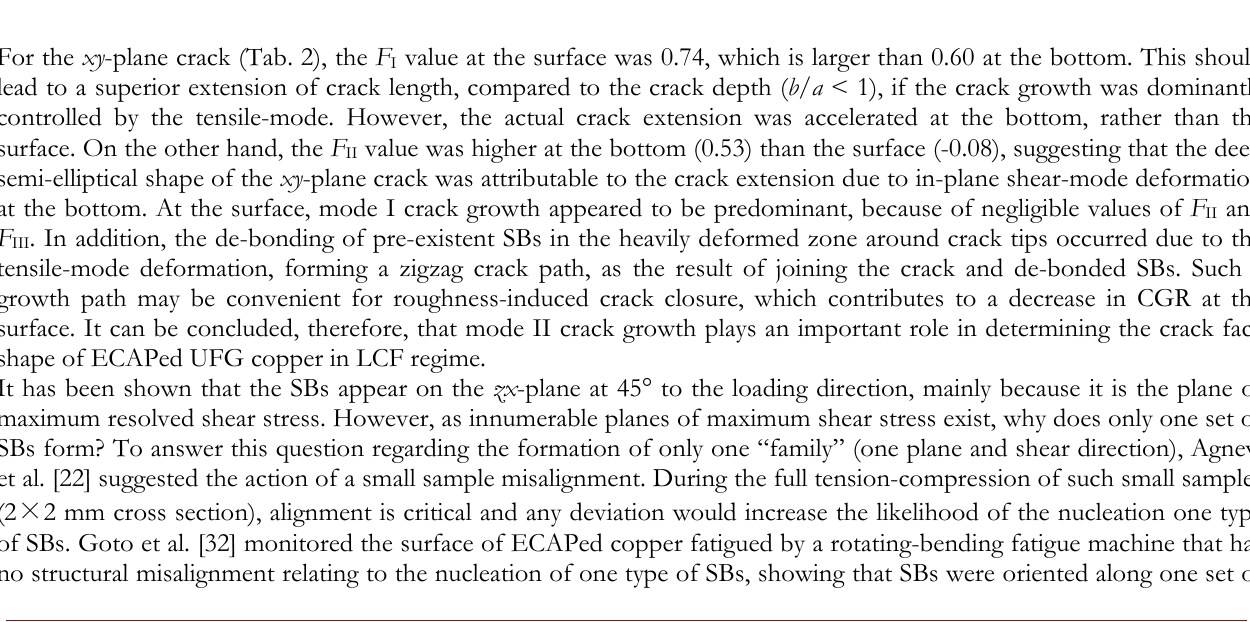
Table 2: Dimensionless stress intensity factors for the xy -plane crack ( b / a = 1.10, a = L